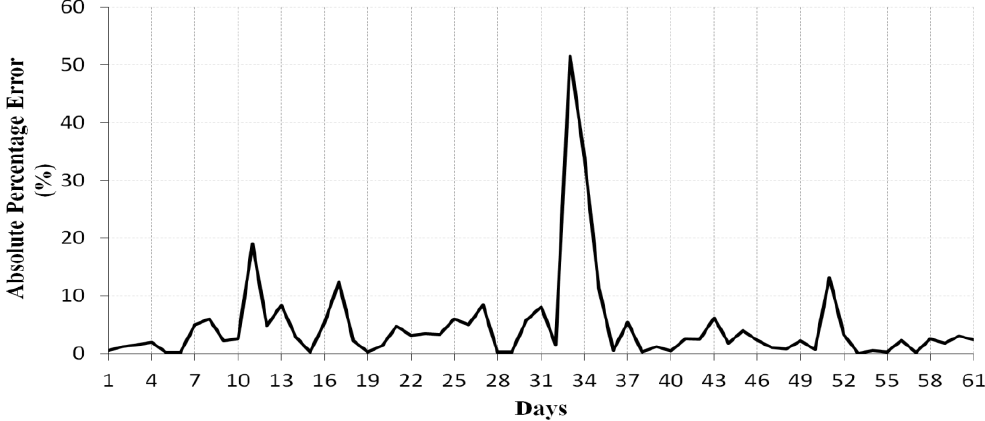
Figure 8. The lowest MAPE values achieved by the ALO-MLP method.